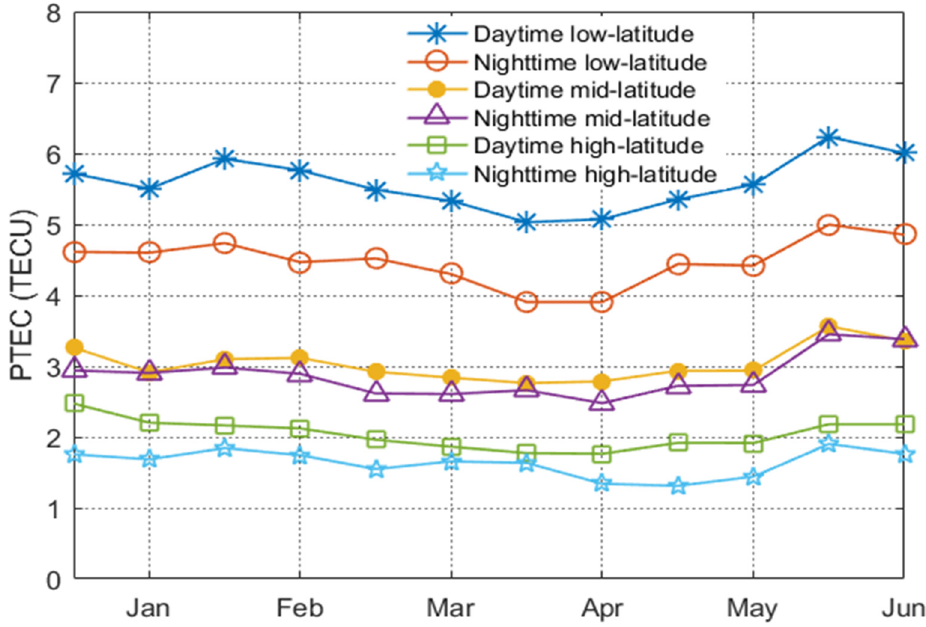
Figure 7. Monthly mean daytime and nighttime PTEC in different geomagnetic latitudes in 2008. Figures 8 and 9 show the monthly and seasonal variations of plasmaspheric TEC in 2014, respectively. Observations of January and February 2015 are also used in in the sub- graph at bottom right of Figure 9. The basic distribution characteristics of plasmaspheric TEC mentioned above still exist. The most obvious difference is that the belts with higher PTEC values are wider during the solar active period, especially in the daytime, which indicates that during the solar active period, a larger region of the plasmasphere can receive strong solar radiation, thus ionizing to generate more charged particles. In terms of numer- ical value, the peak values of PTEC are significantly higher than those in 2008, which are almost double in some months. In June, July and August 2014, the values of plasmaspheric TEC are smaller than those in other months, which is the same as 2008. This phenomenon is also reflected on the seasonal scale, whereby the values of plasmaspheric TEC in northern summer are much lower than those in other seasons. An interesting phenomenon is that the local maximum values of PTEC appear around 12:00 o’clock in the region of geomagnetic latitude -80 ◦ in spring, autumn and winter of the northern hemisphere, which indicates that the charged particles of the plasmasphere will accumulate in this region at noon, and its physical mechanism needs to be further